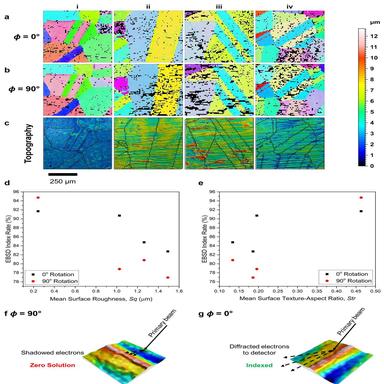
EJM surface anisotropy affects the index rate in EBSD studies. a) EBSD data (0.36 mm2 , 10 μm pixel size) acquired from areas of interest i-iv on the coarsened Ni with striations oriented parallel to the incident beam. b) EBSD acquired under identical conditions of identical areas of interest, with the sample orientation rotated through 90°. See IPF for colouring. c) EBSD zero solution can be spatially correlated with topographic extremes (see grain boundary overlay), see height scale for reference to colou